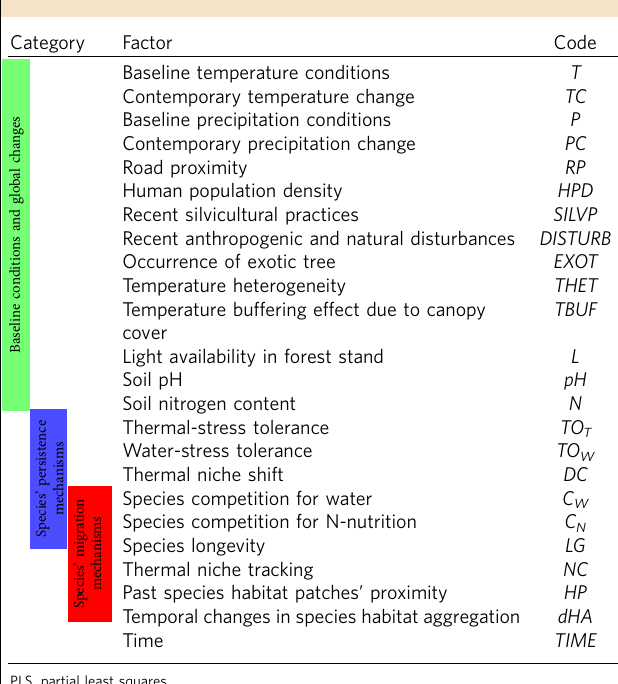
Table 1 | List of the variables tested in the PLS